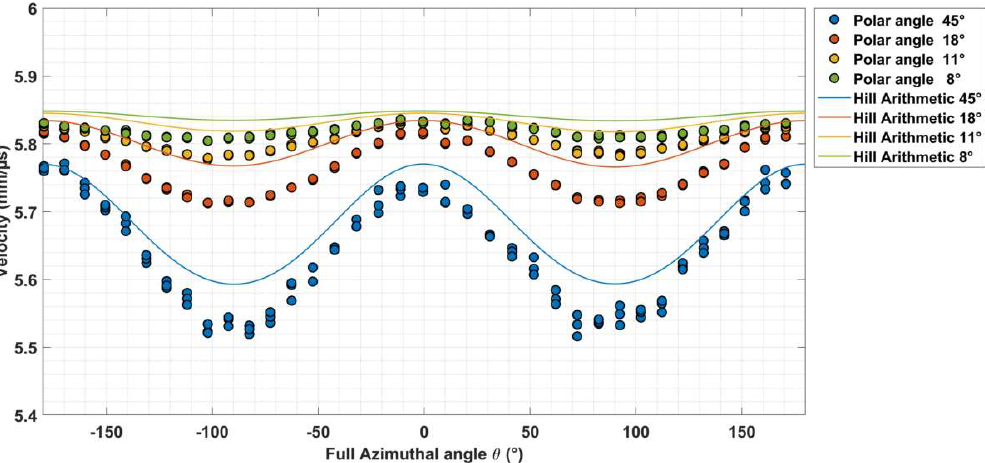
Figure 10. Velocity vs. azimuthal angle θ = ± 180° for the circular scan with GD = ~ 2 times the plate thickness. Echoes 1–4 correspond to polar angles of ρ = 45, 18, 11 and 8°, respectively. The plot contains measurements (circles) from three full revolutions of the generation laser and the corresponding EBSD calculated velocities (solid lines) using Hill arithmetic approximation.